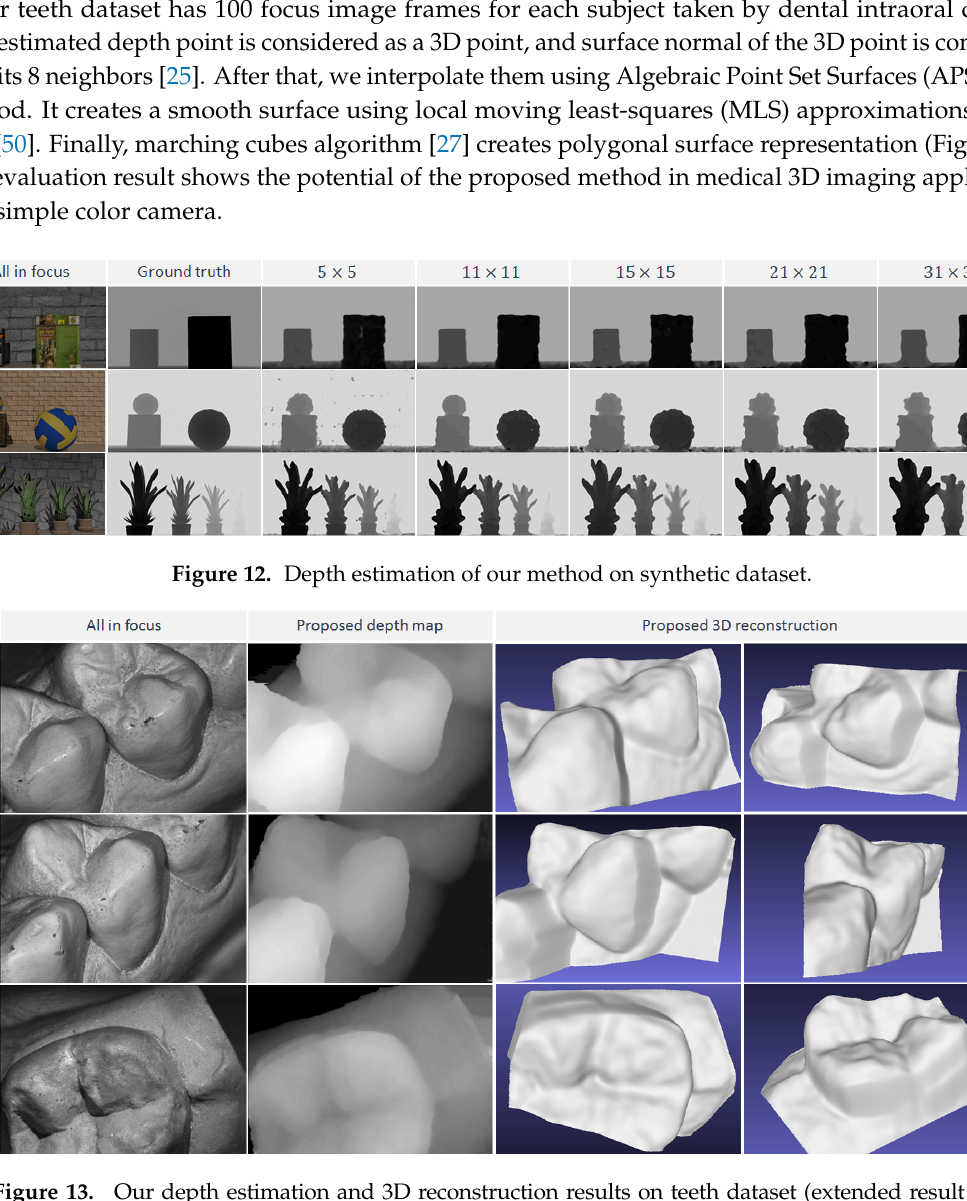
Figure 13. Our depth estimation and 3D reconstruction results on teeth dataset (extended result of Reference